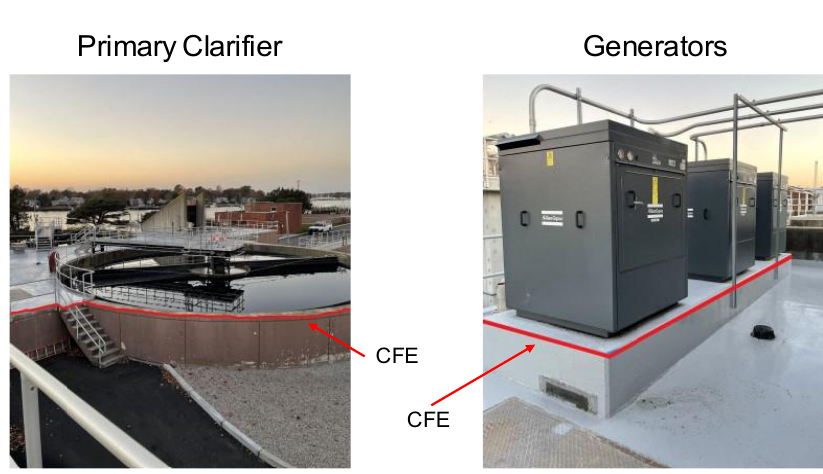
Figure 6. Example of vertical locations of Critical Flood Elevation (CFE) for primary clarifier and generators, Warren WWTF.